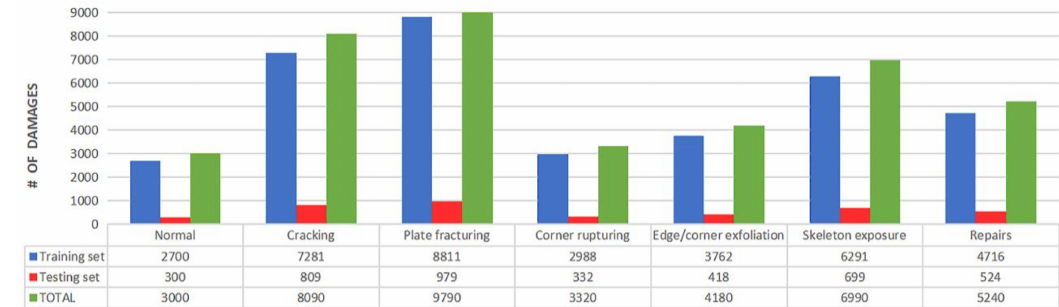
Figure 2. Sample images and seven defect classes.